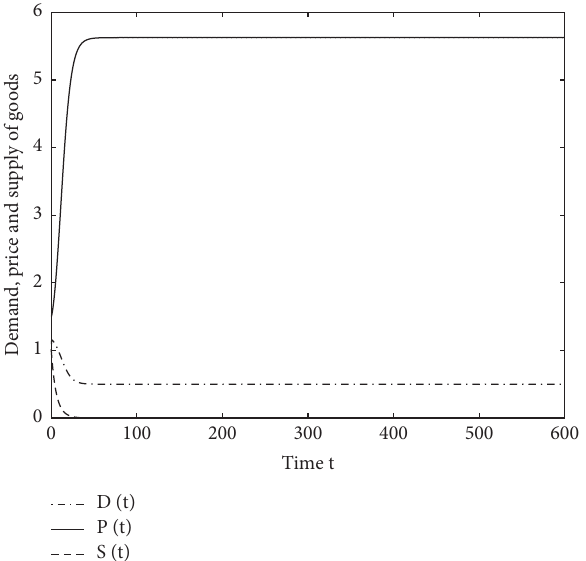
Figure 2: Plane phase diagram of the global asymptotic stability at E